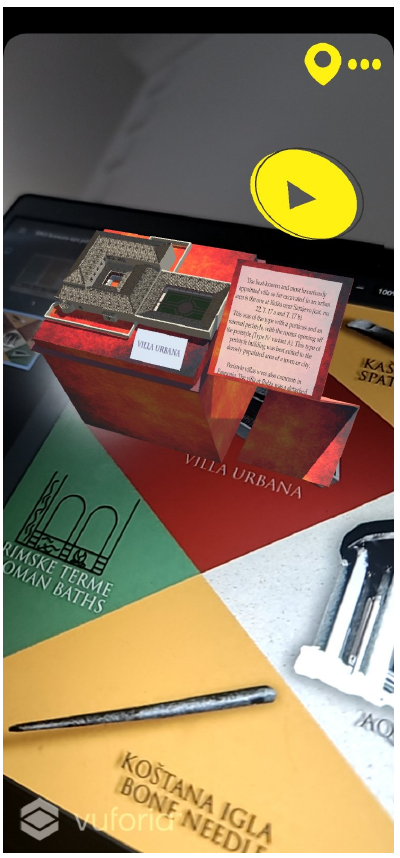
Figure 6. Different types of informative content on the Sarajevo Roman Heritage Augmented Reality